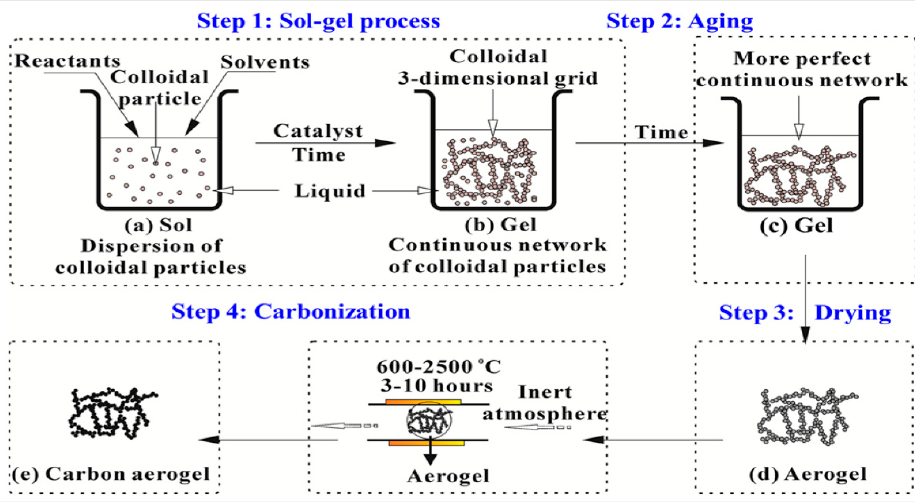
Figure 2. Basic method of producing carbon or polymer aerogels [33].